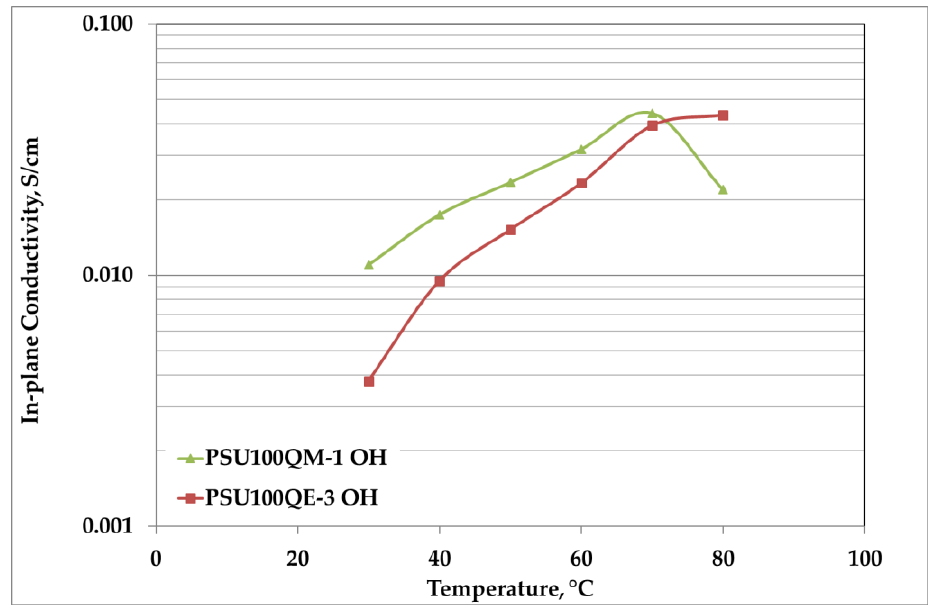
Figure 6. Anion conductivity (Cl − ) of 100% DF samples with different quaternary ammonium groups .